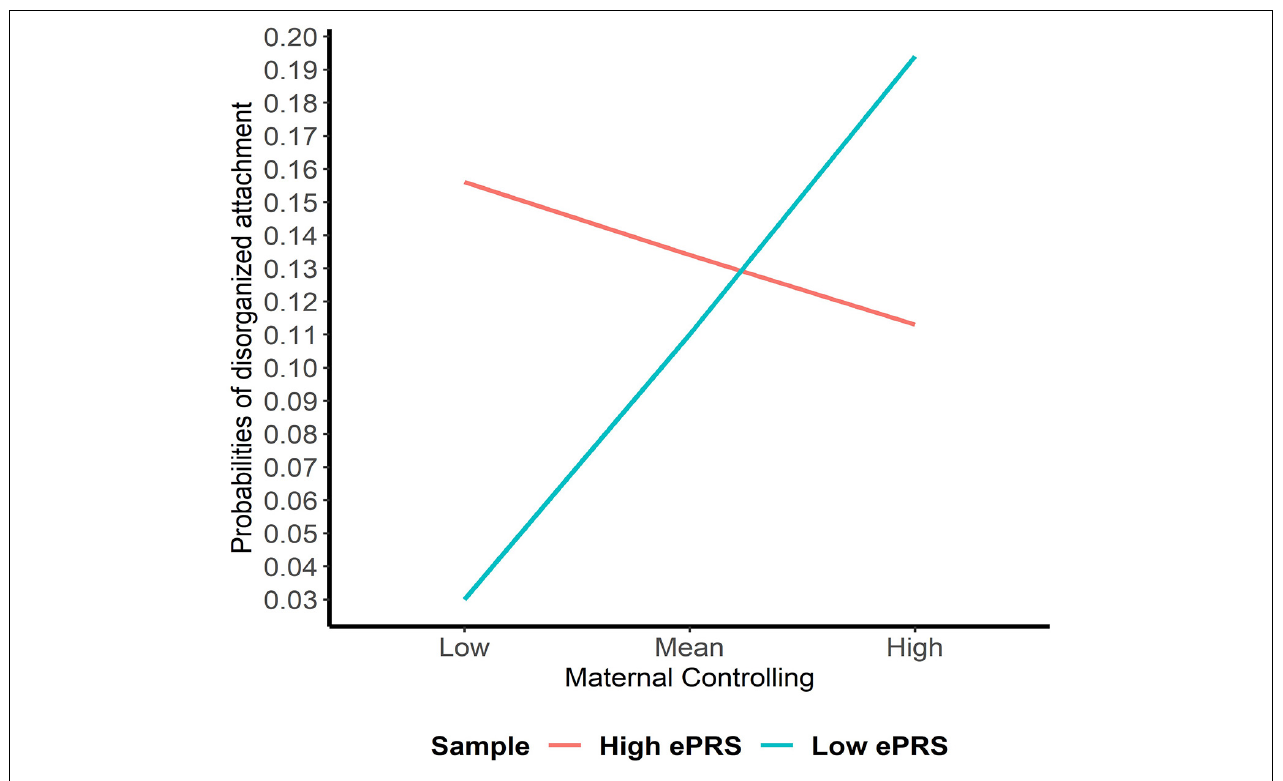
FIGURE 5 | Interaction between Hippocampal Gene Network and Maternal Controlling in Disorganized Attachment. Shows that higher maternal controlling and a high CNR1 ePRS in the hippocampus predicts a lower probability of disorganization. Higher maternal controlling and a low CNR1 ePRS in the hippocampus predicts a higher probability of